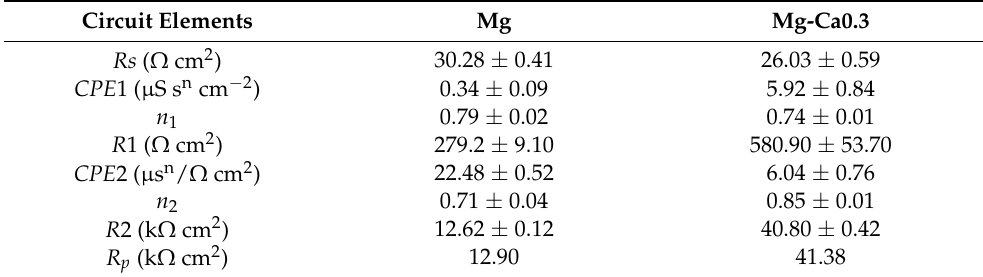
Table 3. Fitting parameters estimated from EIS data of Mg and Mg-Ca0.3 exposed for 24 h to Hank’s physiological solution at 21 ◦